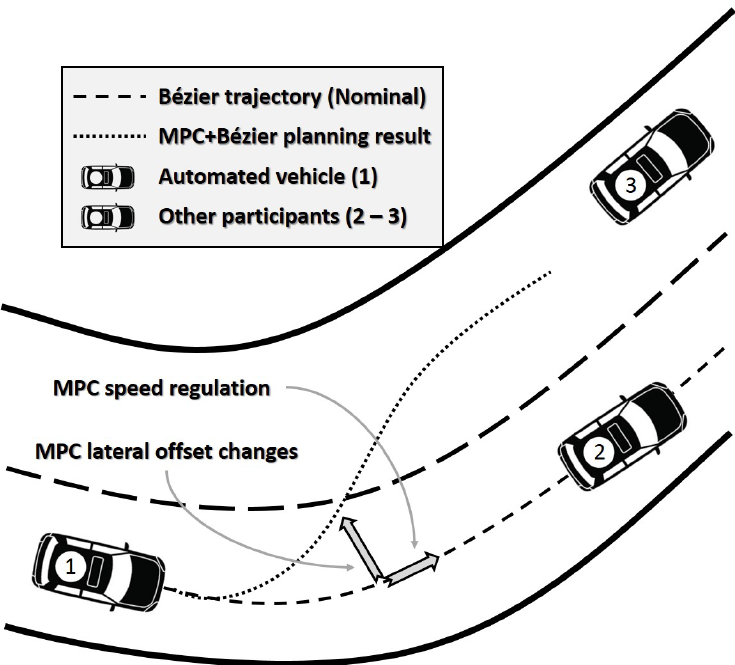
Figure 2. Problem segmentation in the overtaking